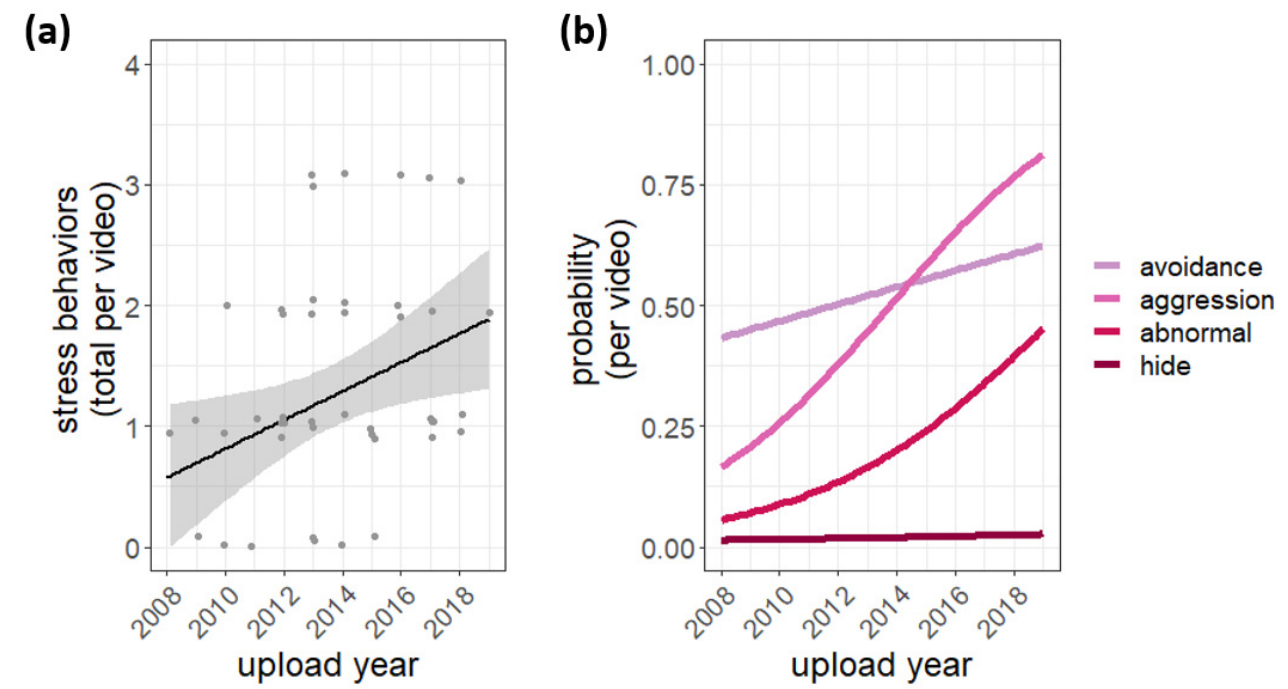
Figure 4. Cub stress behavior over time. ( a ) The dots are the total number of cub stress behaviors in each video (4 max). The black line and grey band are the best-fit linear least squares line and its associated standard error ( p < 0.02). ( b ) Each line represents the logistic regression model for the probability of observing a particular poor husbandry practice in a video for each year. All stress behaviors tended to increase over time, but due to low power, testing statistical significance for each behavior in isolation was not